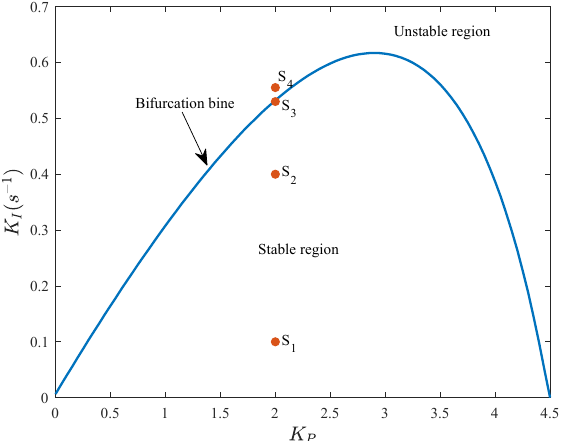
Figure 4. Stable region of the DFVSPSPS.